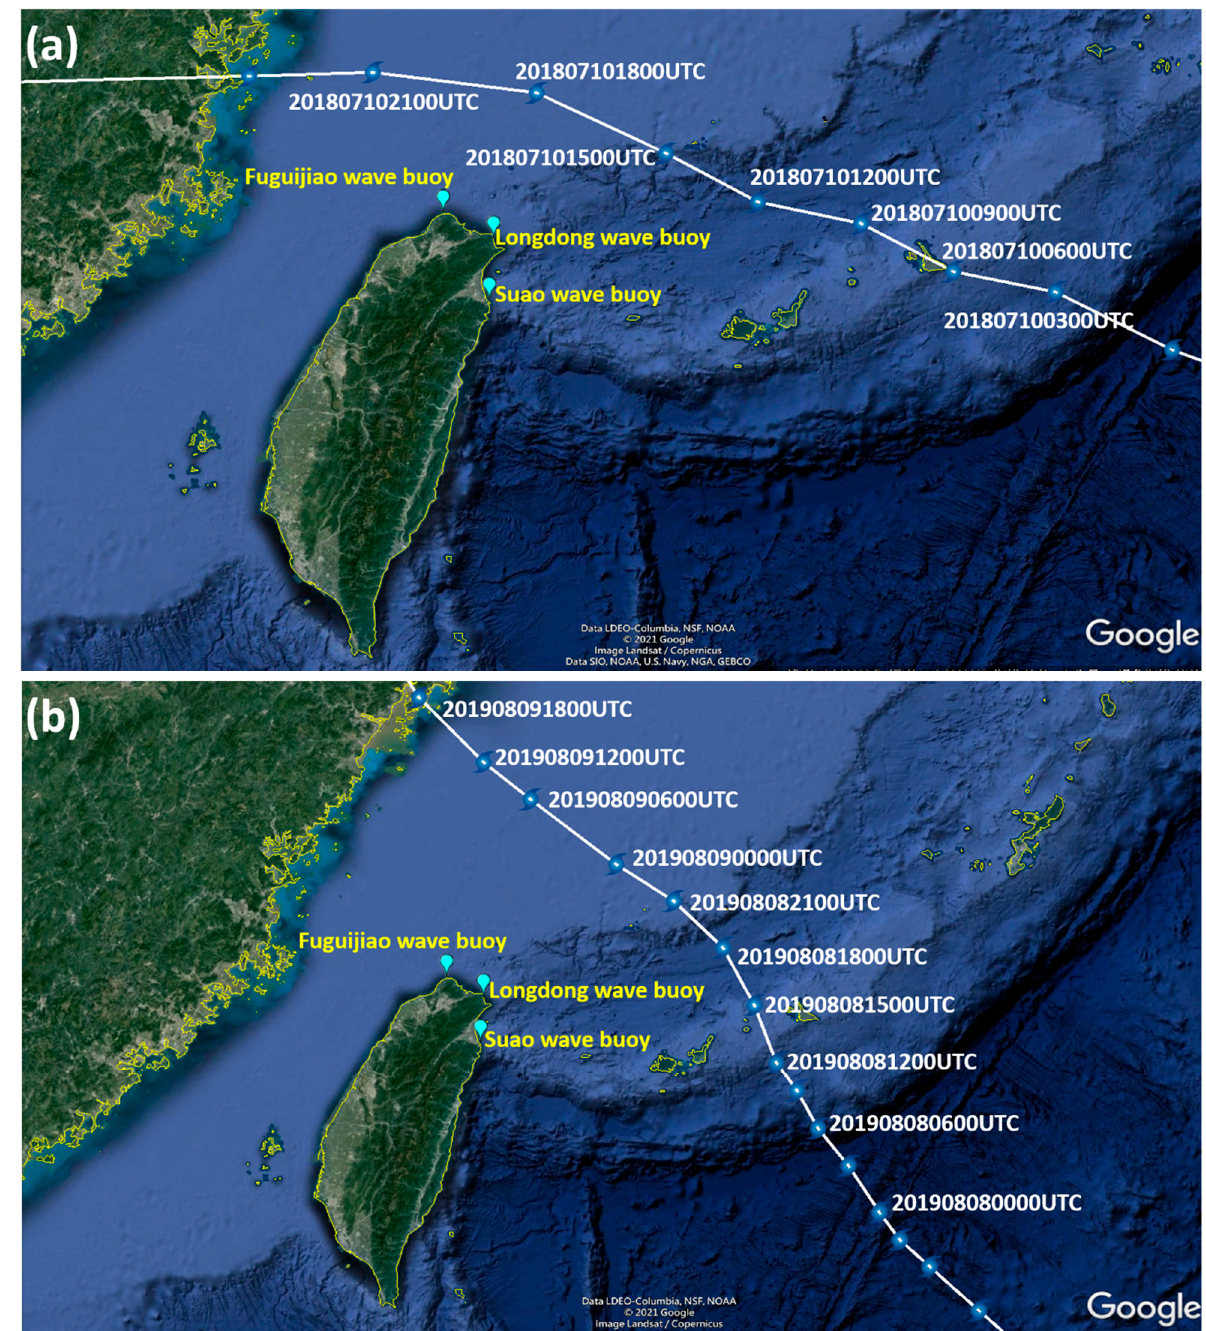
Figure 1. Tracks and arrival times of ( a ) Super Typhoon Maria in 2018 and ( b ) Lekima in 2019. The locations of wave buoys adopted in the present study are marked in cyan (Data source: Regional Specialized Meteorological Center (RSMC) Tokyo-Typhoon Center).